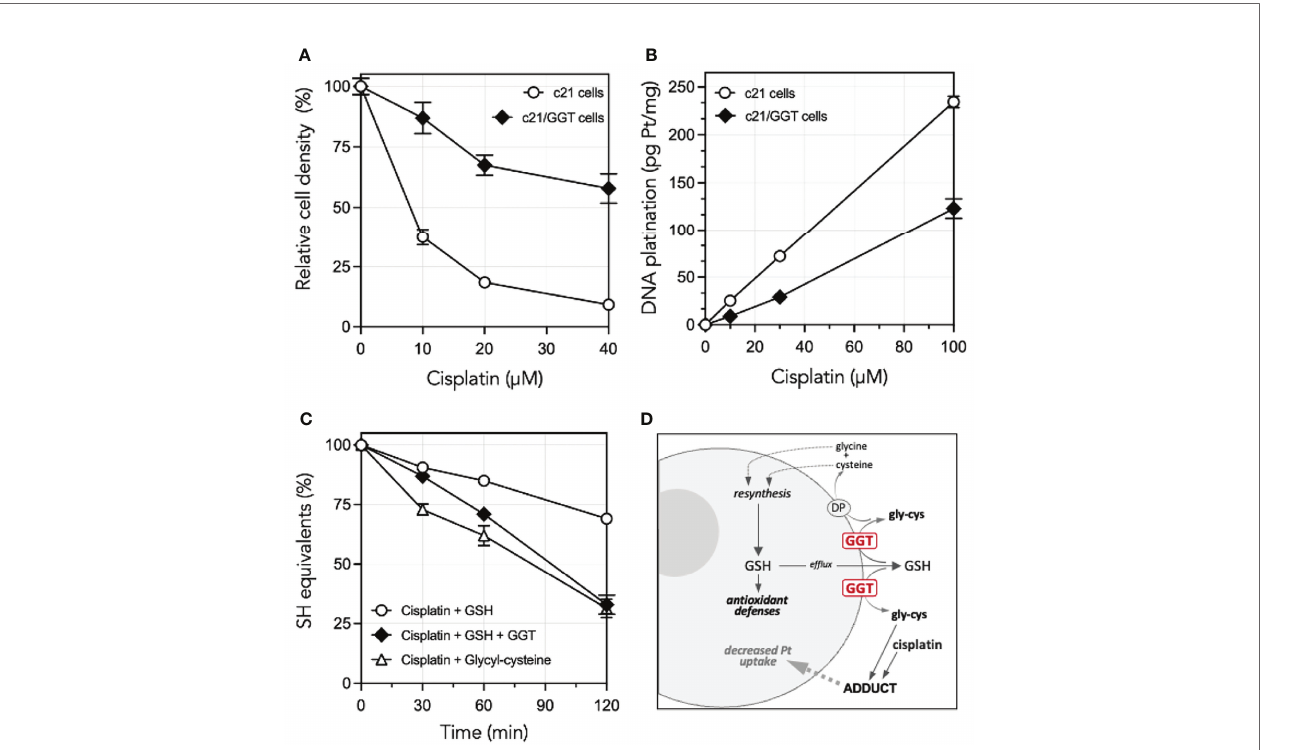
FIGURE 1 | Cisplatin resistance of GGT1-expressing melanoma cells, degrees of DNA platination and differential reactivity of cisplatin with low mol. weight thiols. (A) Cisplatin sensitivity of c21 melanoma cells as compared to their GGT1-transfected (c21/GGT) counterparts. Cells were incubated 24 h with cisplatin and cell number was determined by WST-1 assay. Results are expressed as % of untreated controls, and are means ± SD (N = 12 – 36). (B) Corresponding levels of DNA platination in the same two clones as in A. Cells were exposed to cisplatin for 1 h. Platination was measured by inductively coupled plasma mass spectroscopy. Values shown are means ± SD (N = 3). (C) Reactivity with cisplatin with GSH in absence ( 〇 ) or presence of 200 mU/ml puri fi ed GGT1 ( ♦ ), or with the product of GGT1-mediated metabolism of GSH, glycyl-cysteine ( D ). SH groups were assessed at time intervals in a mixture containing 1.5 mM cisplatin and 3 mM GSH or glycyl-cysteine. Values shown are means ± SD (N = 3). (D) Proposed mechanisms underlying the GGT1-mediated resistance of cancer cells to cisplatin cytotoxicity. Modi fi ed, from Paolicchi et al. (14), Daubeuf et al. (15) and Franzini et al.